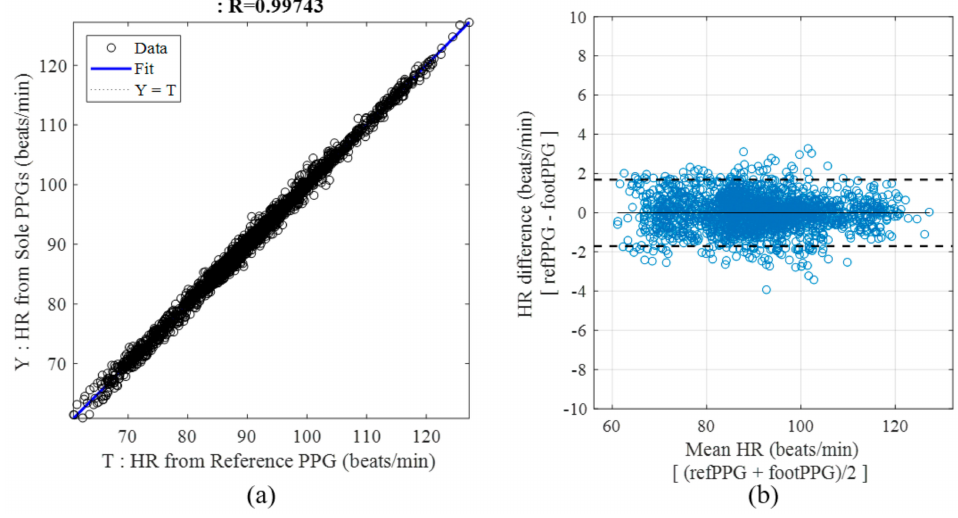
Figure 8. Scatter plots of HRs estimated by foot PPG and reference HRs with 40 time windows for 53 participants. ( a ) Linear regression plot. ( b ) Bland–Altman plot.